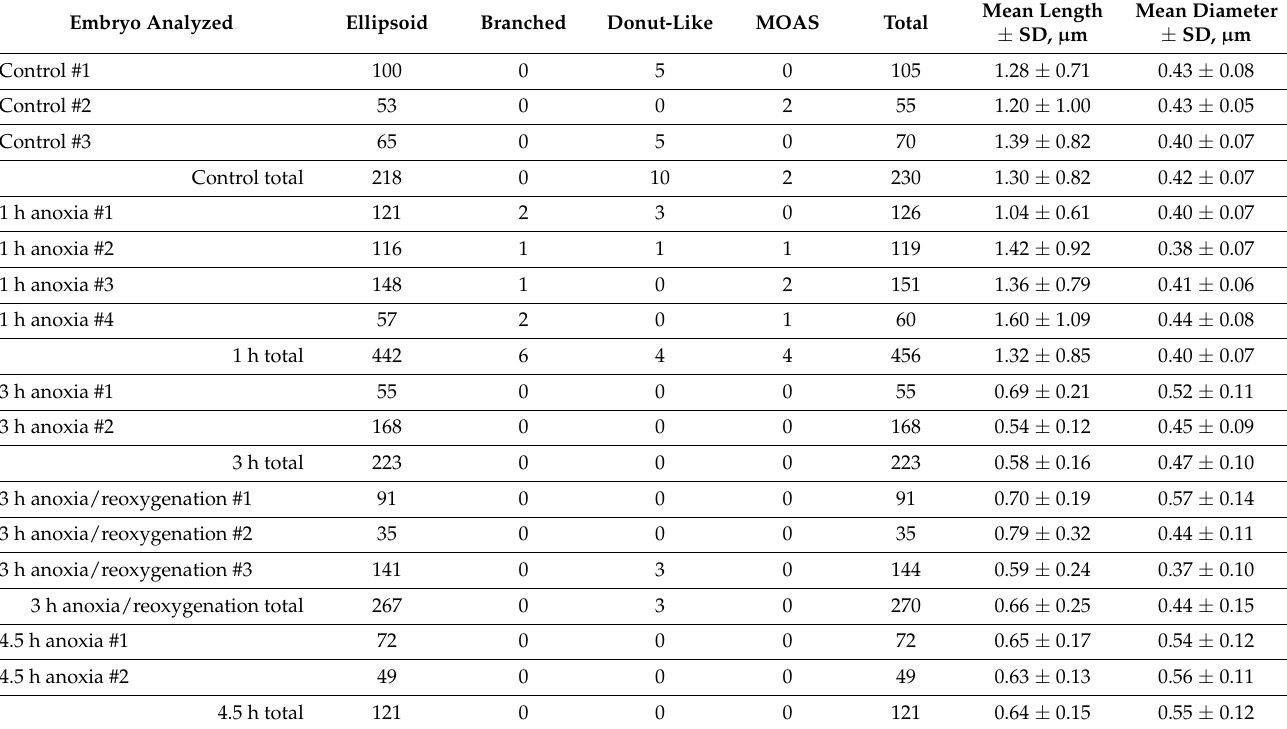
Table 2. Morphologic characteristics of 3D-reconstructed mitochondria from SVZ of E13 mouse embryo cerebral cortex in control, anoxic, and reoxygenation